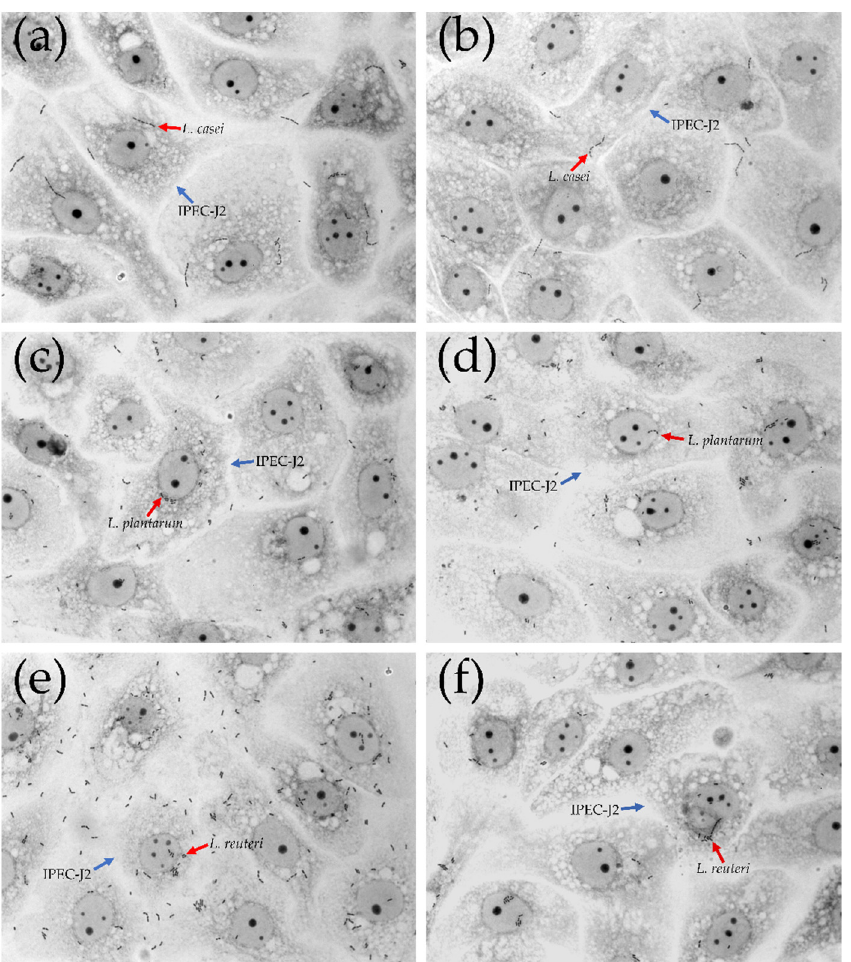
Figure 4. Adhesion of L. casei , L. plantarum and L. reuteri to IPEC-J2 cells. Representative microphotographs with 100× magnification (oil immersion). ( a ) L. casei ; ( b ) L. casei + LiCl; ( c ) L. plantarum ; ( d ) L. plantarum + LiCl; ( e ) L. reuteri ; ( f ) L. reuteri + LiCl. Red arrows indicate lactobacilli strains; blue arrows indicate IPEC-J2 cells.